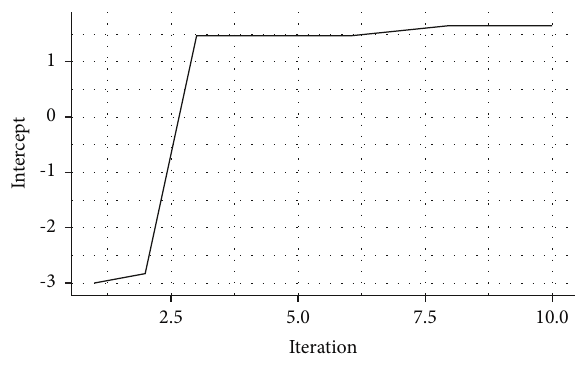
Figure 1: Intercept estimation